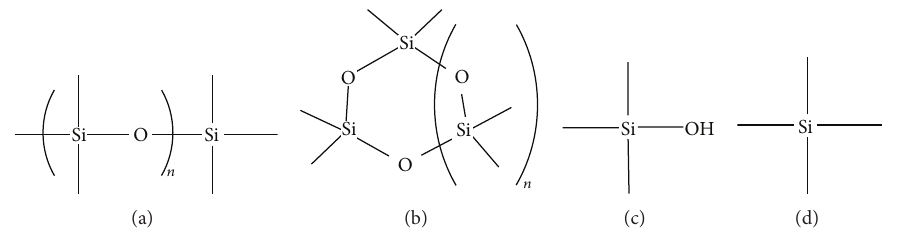
Figure 1: Structural formulas of VOSiCs: (a) linear ( 1 < 𝑛 < 3 ), (b) cyclic ( 1 < 𝑛 < 5 ), (c) trimethylsilanol (TMSol), and (d) tetramethylsilane